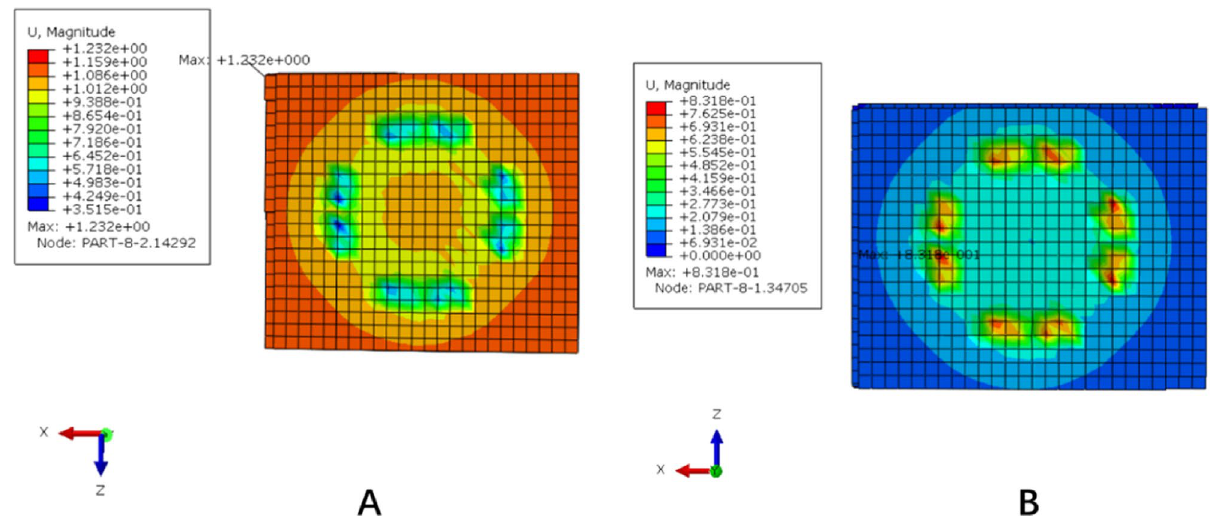
Figure 6. The subsidence and displacement nephogram of the traditional titanium mesh cage (TTMC). ( A ) Upper polyurethane foam blocks subsidence displacement nephogram; ( B ) lower polyurethane foam blocks subsidence displacement nephogram (Abaqus 2016, SIMULIA Co, USA).